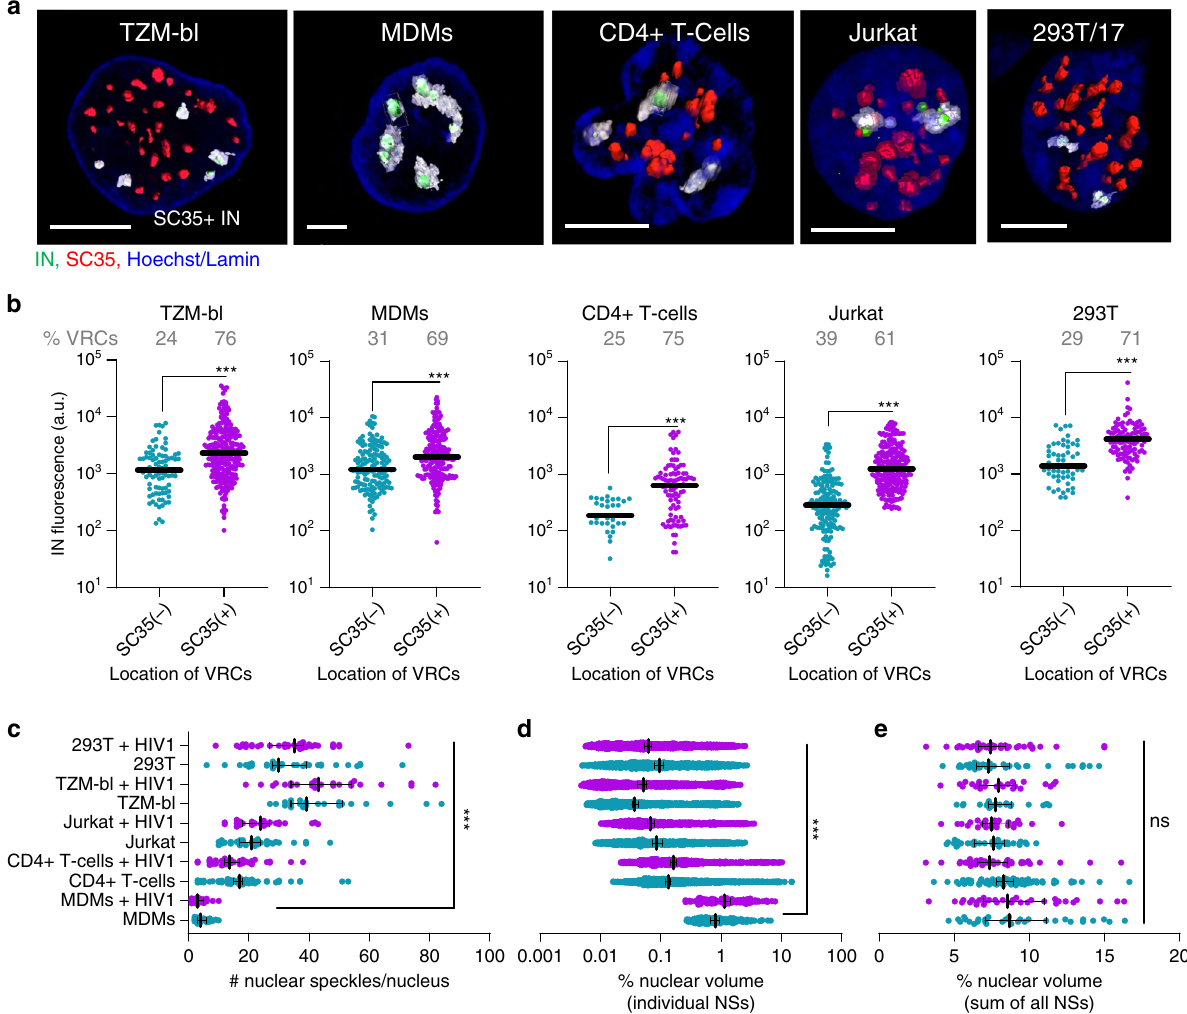
Fig. 3 NSs are preferred HIV-1 accumulation sites in different cell types. a – e MDMs, HEK293T, and TZM-bl cells were infected at MOI of 5 (determined on TZM-bl cells); Jurkat cells and primary CD4 + T cells were infected in suspension with the same virus supernatant and later adhered to a 8-well coverslip for microscopy analysis. All cell types were fi xed at 6 hpi (uninfected cells were used as controls). Cells were immunostained for NSs (SC35) and lamin in TZM-bl and MDMs; the nuclei of T cells and HEK293T cells were stained with Hoechst-33342. NSs (SC35( + )) compartments were identi fi ed by three-dimensional image analysis. a 3D-rendered of images showing NSs (red), IN puncta (green), and nuclei (blue). NSs encompassing HIV-1 complexes are colored transparent gray. Scale bar: 5 μ m. ( b ) Fluorescence intensities of IN puncta inside (SC35( + )) and outside (SC35( − )) nuclear speckles. c The number of NSs per nucleus in different cell types. d Percent of nuclear volume occupied by individual NSs. e Percent of nuclear volume occupied by all speckles. Infected cells (red symbols) are marked with cell type name + HIV-1. Data in ( b – e ) are presented as median values± SEM at 95% CI. N > 50 nuclei for each cell type from >3 independent experiments in HEK293T and Jurkat cells, from three donors in primary CD4 + T cells, and >5 independent experiments in TZM-bl cells and MDMs. A total of 124 nuclear IN puncta were analyzed in CD4 + T cells and >200 IN puncta were analyzed in all other cell types ( b ). Statistical signi fi cance between uninfected MDMs and other cell types in ( b – e ) was determined using a nonparametric Mann – Whitney